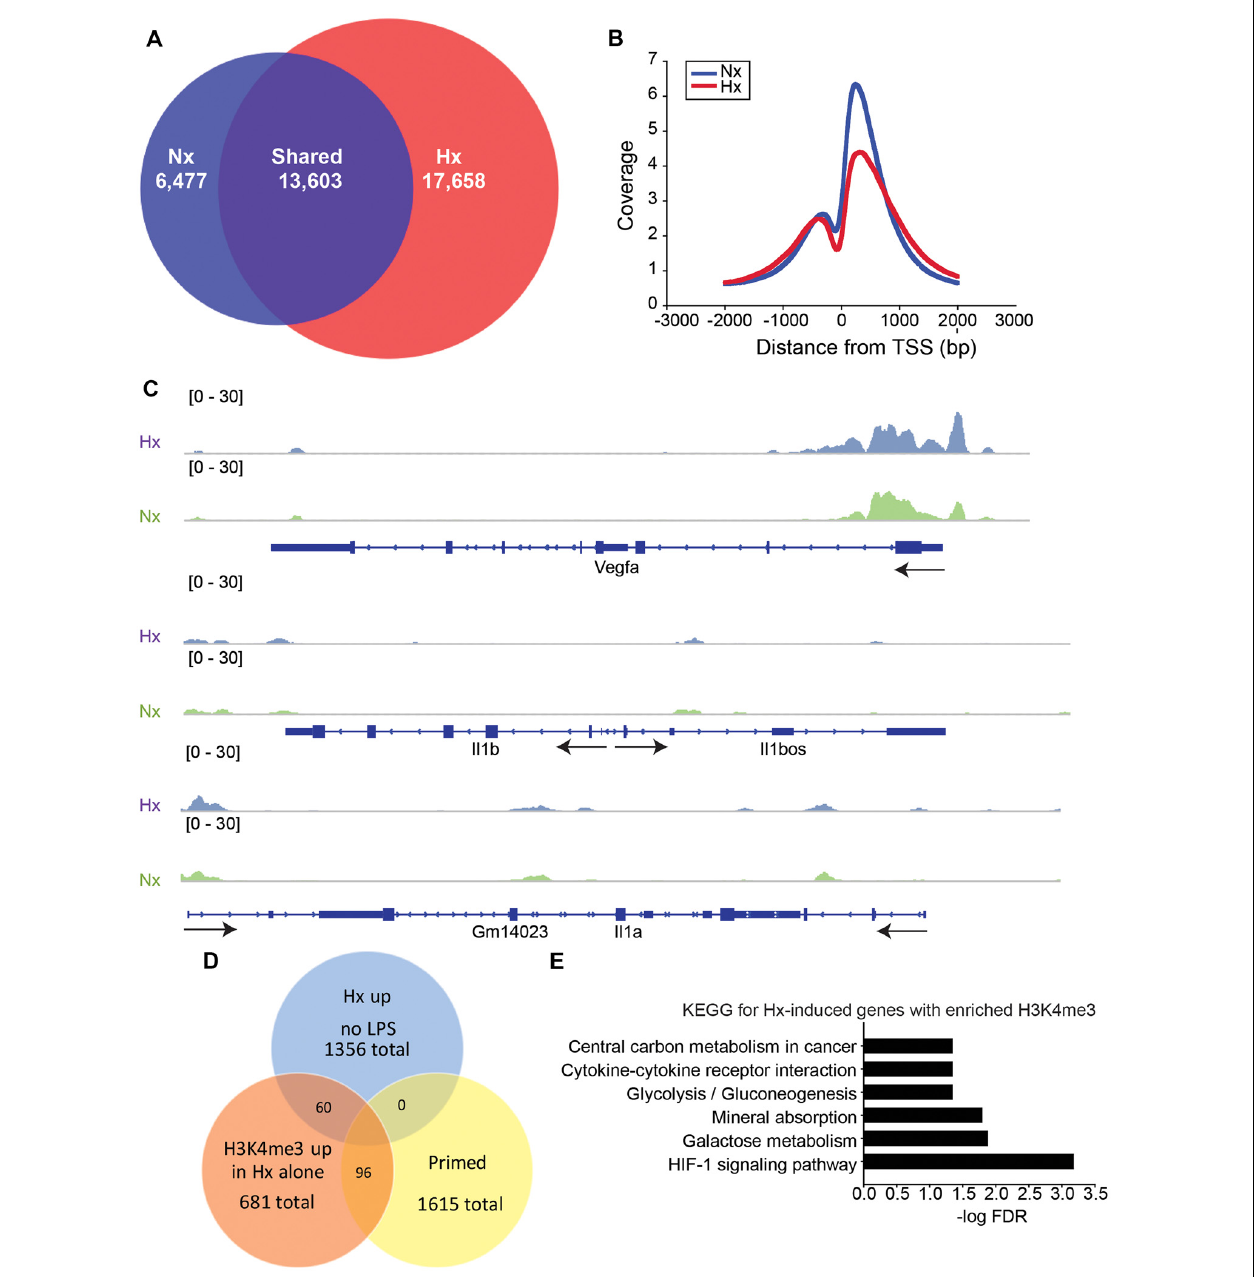
FIGURE 5 | Hypoxia increases global H3K4me3, but not at primed genes. (A) Venn diagrams showing the total number of all unique and shared H3K4me3 peaks enriched 4-fold above 10% input in Nx and Hx conditions. Peak analyses were performed on merged consensus tag directories in n = 3 replicates/treatment. (B) Histogram of the location of all H3K4me3 peaks enriched in Nx (blue line) and Hx (red line) relative to the transcription start site of each gene. Coverage is defined as the ChIP fragment depth (per bp per peak). (C) Representative integrative genomics viewer (IGV) images of H3K4me3 at Vegfa , a Hif1a target gene, and at Il1b and Il1a , two of the top 100 primed genes with the largest fold changes in gene expression. (D) Venn diagram showing the number of Hx-induced genes vs. “primed” genes that have increased H3K4me3 at the transcription start site after Hx exposure. (E) KEGG Pathway analyses of the 60 genes upregulated by Hx that also have a concomitant increase in H3K4me3 at the transcription start